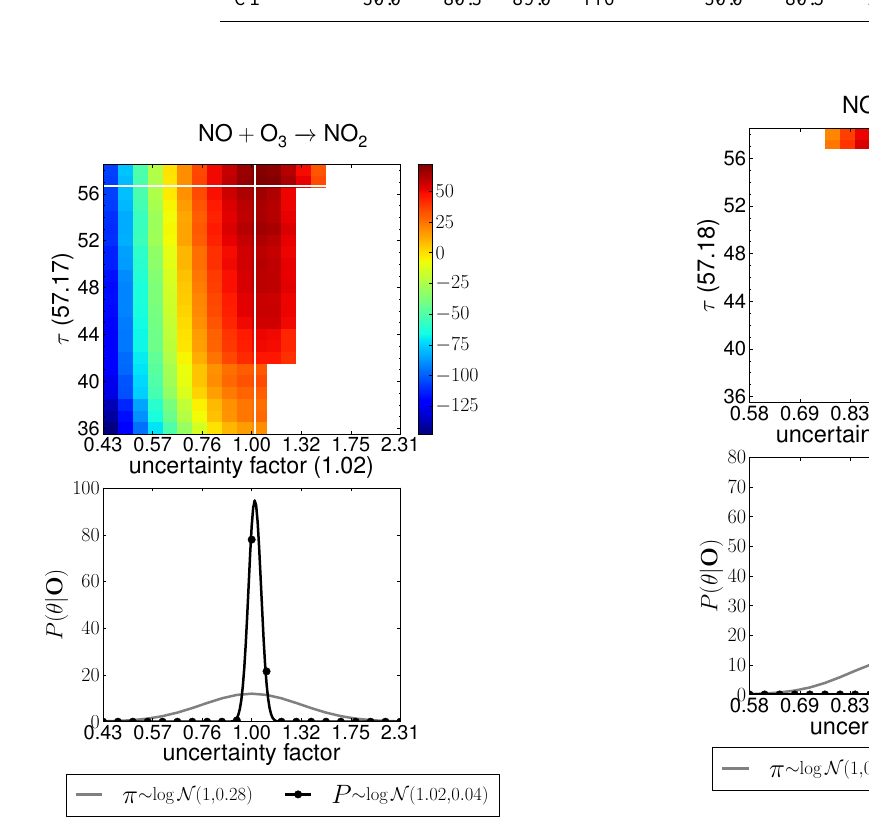
hν → Fig. A2. Same as Fig. A1 for the NO 2 NO + O 3 P reaction. Fig. A2. Same as Fig. A1 for the NO 2 hν → NO + O 3 P reaction. humidity drive reaction rates (gas-phase and heterogeneous) and thermal partitioning of to aerosols. The difference is driven by adiabatic cooling or warming and mixing with background air. The rates of adiabatic processes are not well understood, but are thought to occur within an hour. In this study, we see that environmental conditions in ini- tial air parcels are distinct from the base conditions. The initial conditions are taken from samples with the highest XNO 2 :HNO 3 ratios (top 12.5 %). The initial conditions